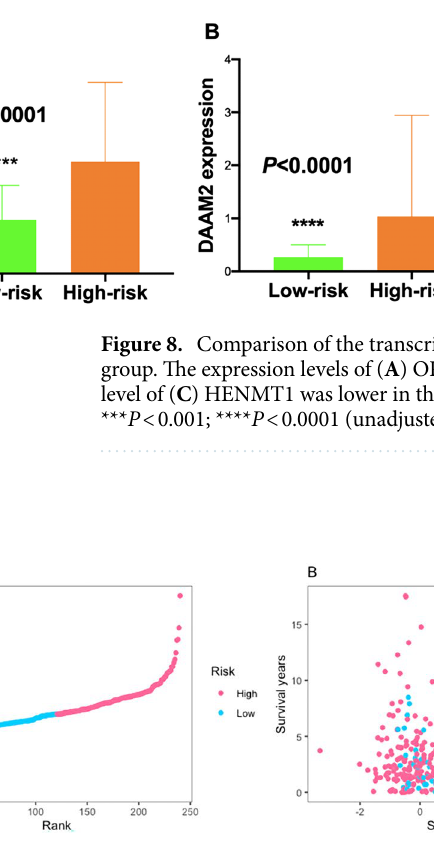
Figure 9. Performance of the prognostic model in classifying patients into the low-risk and high-risk groups. ( A ) Risk score distribution based on the four-mRNA signature. ( B ) Risk score distribution in the groups stratified by survival status based on the four-mRNA signature. ( C ) Heat map showing the expression of the 4 key mRNAs in low-risk and high-risk groups. The color from blue to red shows a trend from low expression to high